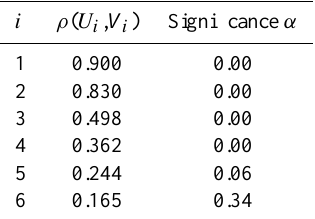
Table 4. Canonical Correlation Analysis: level of significance α of the null-hypothesis that the i th through the 6 th correlations are all